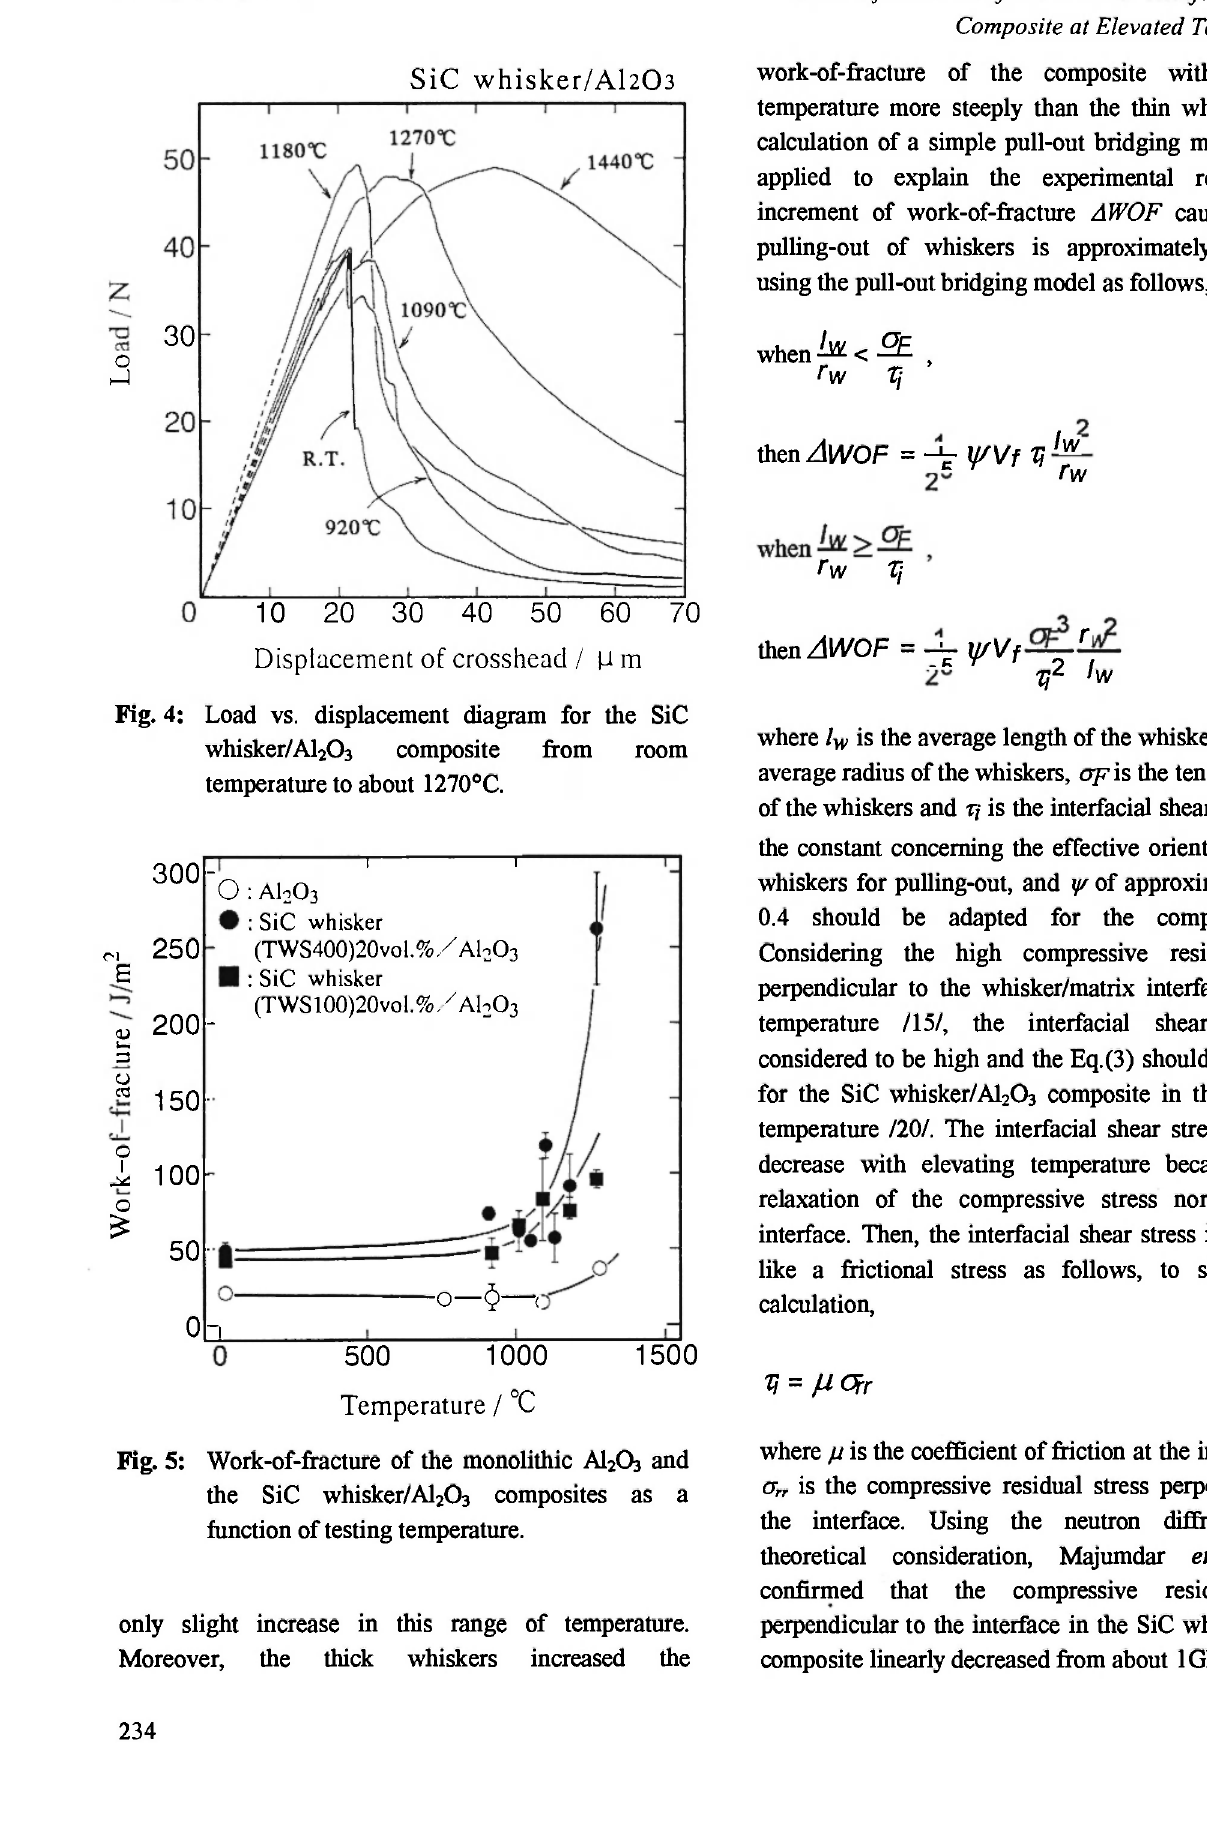
0 composites as a 2 3